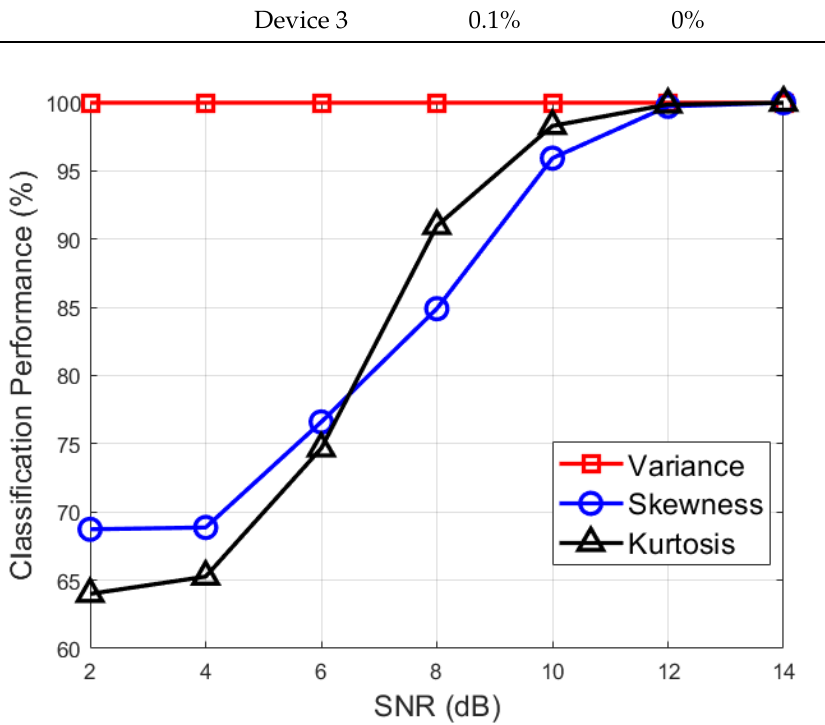
(a) 2nd harmonic (b) 3rd harmonic Figure 9. Statistical feature space representation of second and third harmonics data, SNR=2 dB. features. We present scattered plots with a noise level of SNR = 2 dB as before for comparison purposes. 260 Table 2. Confusion matrices for each harmonic in 3D statistical space for SNR=8 dB. SNR = 8 dB 2nd Harmonic